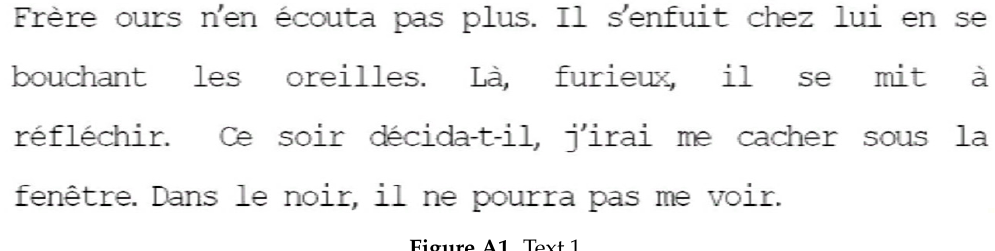
Figure A1. Text 1.